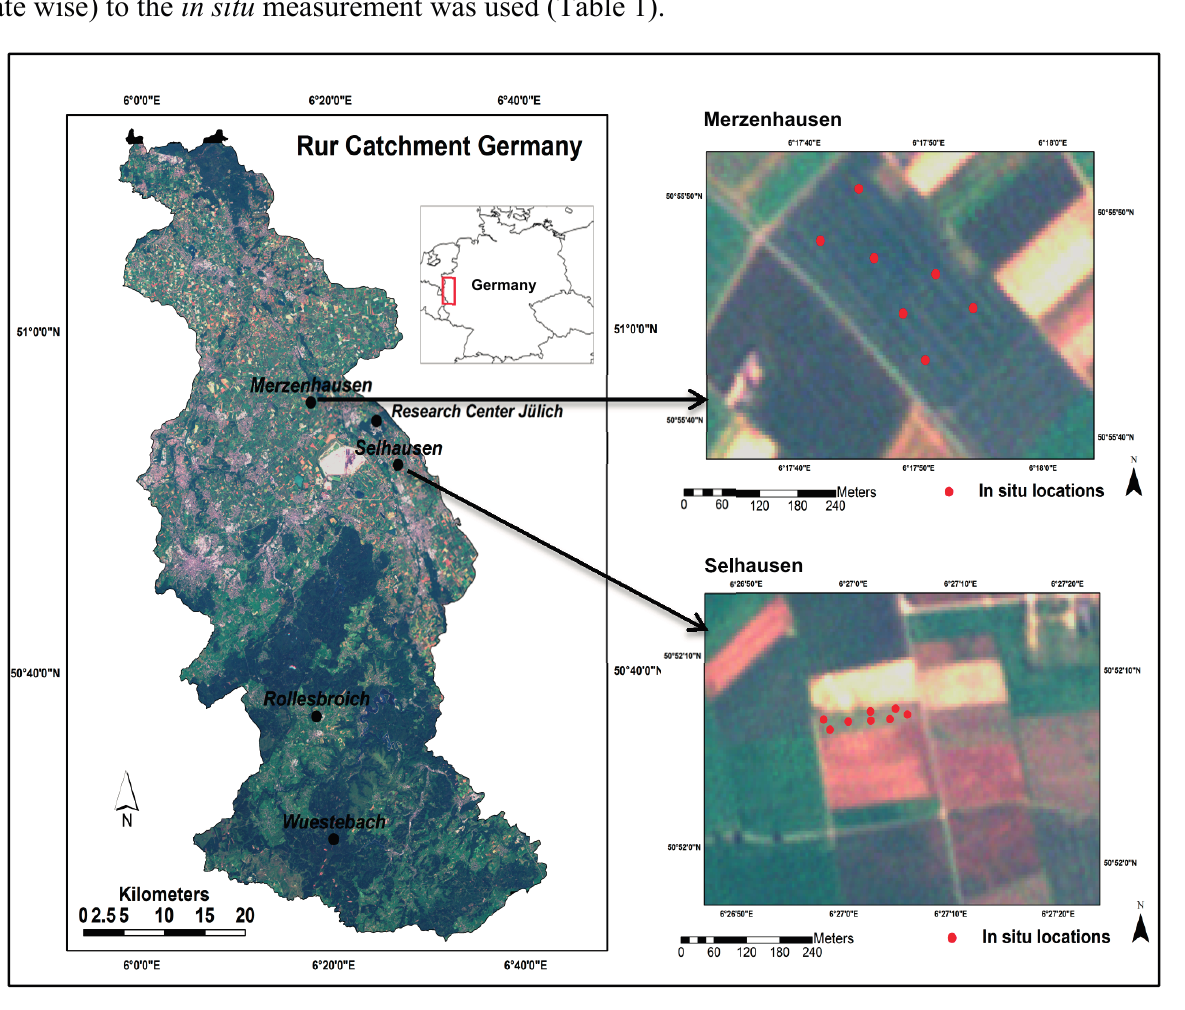
Figure 1. The Rur Catchment (Germany), as seen by RapidEye on 27 June 2011. Individual test sites at Selhausen and Merzenhausen are shown with sampling